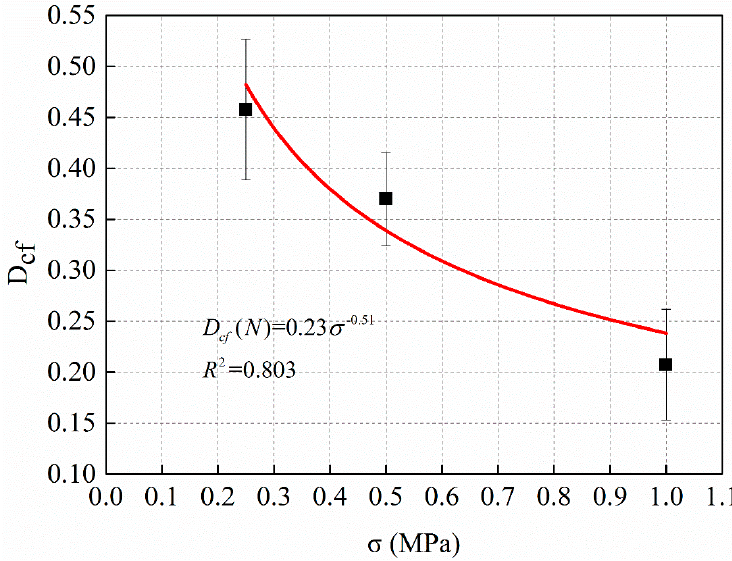
Figure 13. The relationship between critical damage variable and stress level σ .